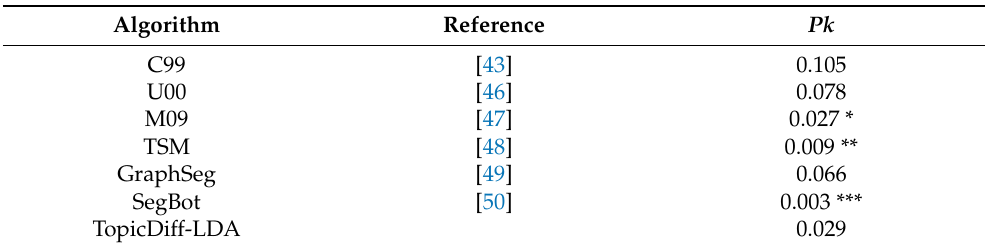
Table 2. Segmentation results on the Choi dataset (unless noted otherwise, text segmentation in an unsupervised mode is